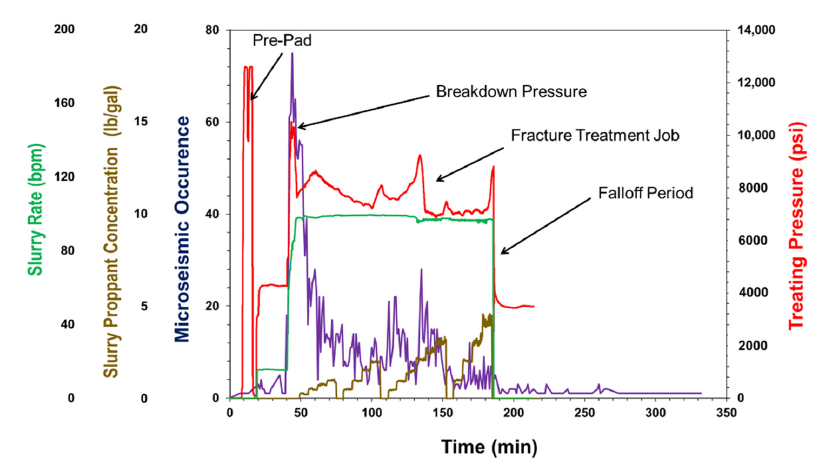
Figure 7. DFIT operations for W2, presenting injection and pressure profiles.